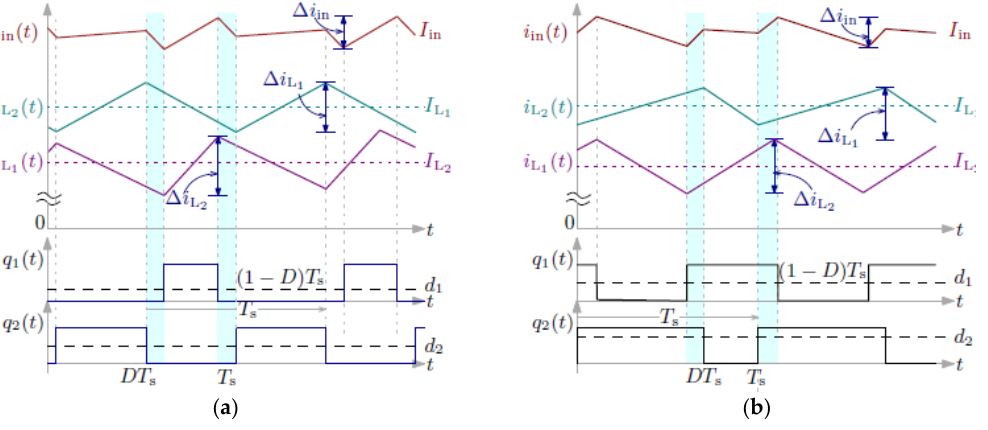
Figure 6. ( a ) D 1 = 30%, D 2 = 50%; (b) D 1 = 30%, D 2 =